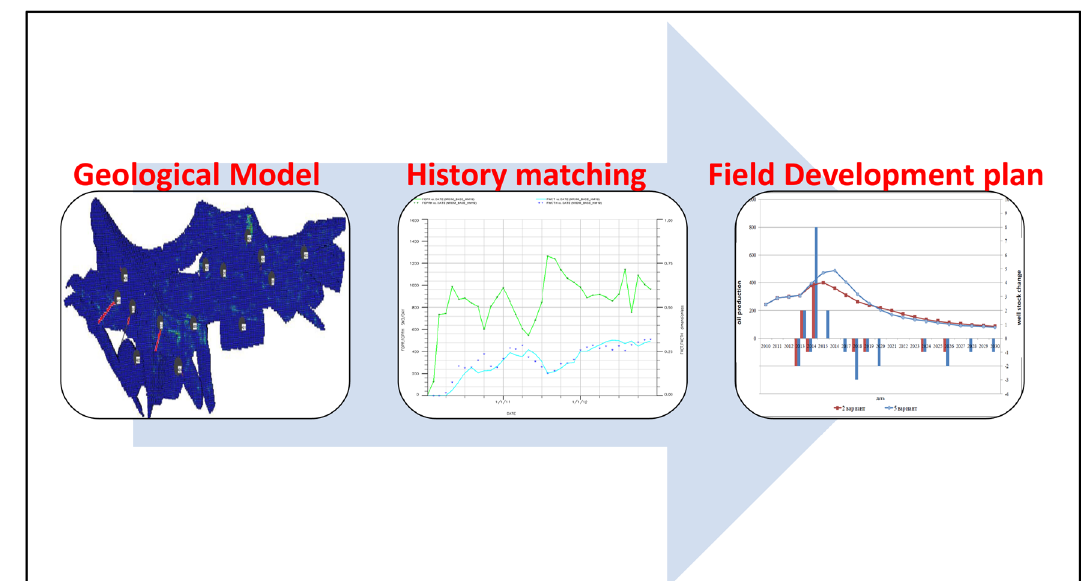
Fig. 1 The general sketch of this study